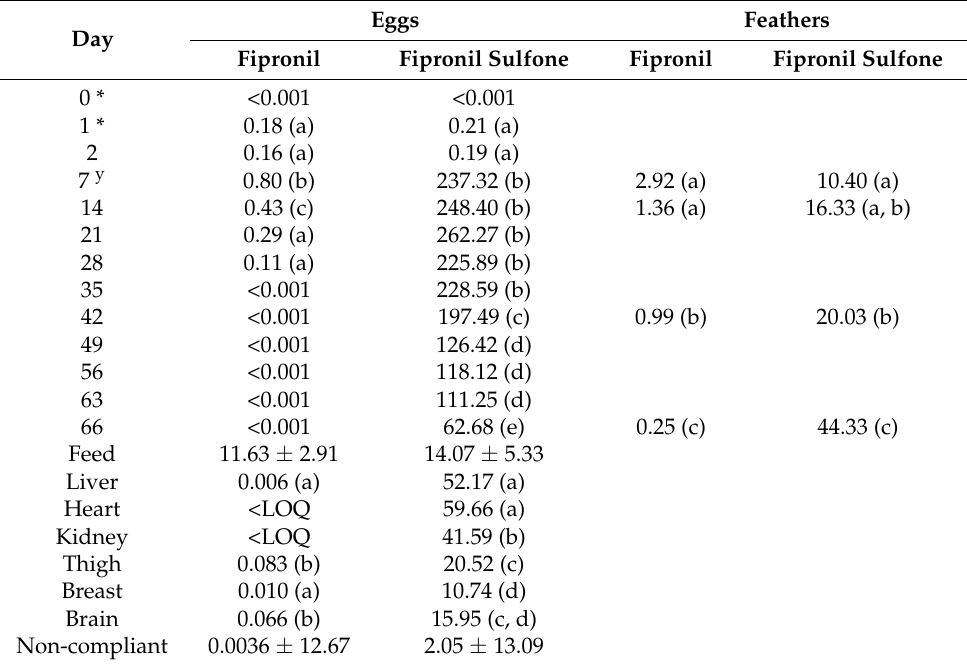
Table 3. Concentrations of fipronil and fipronil sulfone (mg/kg) in the samples from the feeding experiment (trial